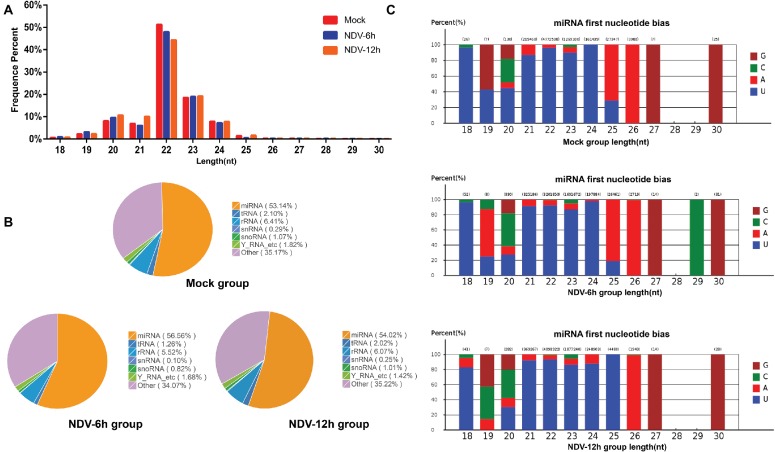
Overview of small RNA deep sequencing data. (A) Length distribution of the clean reads measured by deep sequencing. The number of reads is indicated in percentage. Length of most miRNAs in mock, NDV-6 h, and NDV-12 h DF-1 cells was 21–24 nt. (B) Pie charts of small RNA-seq showing the percentage of small RNA components in mock, NDV-6 h, and NDV-12 h groups. (C) The range in size and base bias at the first position of miRNA identified in mock, NDV-6 h, and NDV-12 h groups. The x-axis indicates miRNAs’ lengths from 18 to 30 nt. The y-axis indicates the percentage of the base bias of miRNAs at the first position of each length.